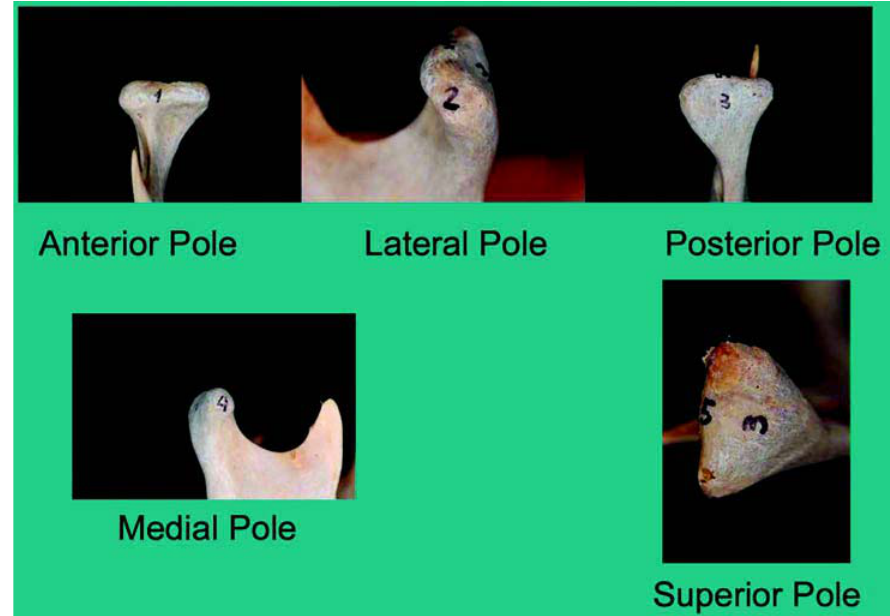
FIGURE 1- Classification of the head of the mandible by region